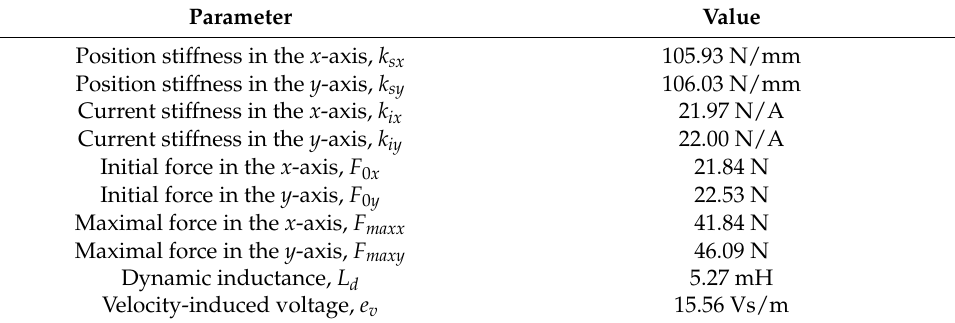
Table 2. Rated parameters of the